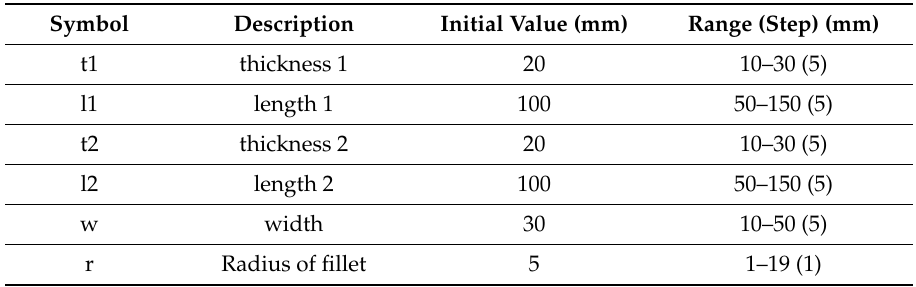
Table 4. The used design parameters (factors) in the optimization of the L ‐ Bracket, their description, initial value, allowable range, and value increment (step) in parentheses.